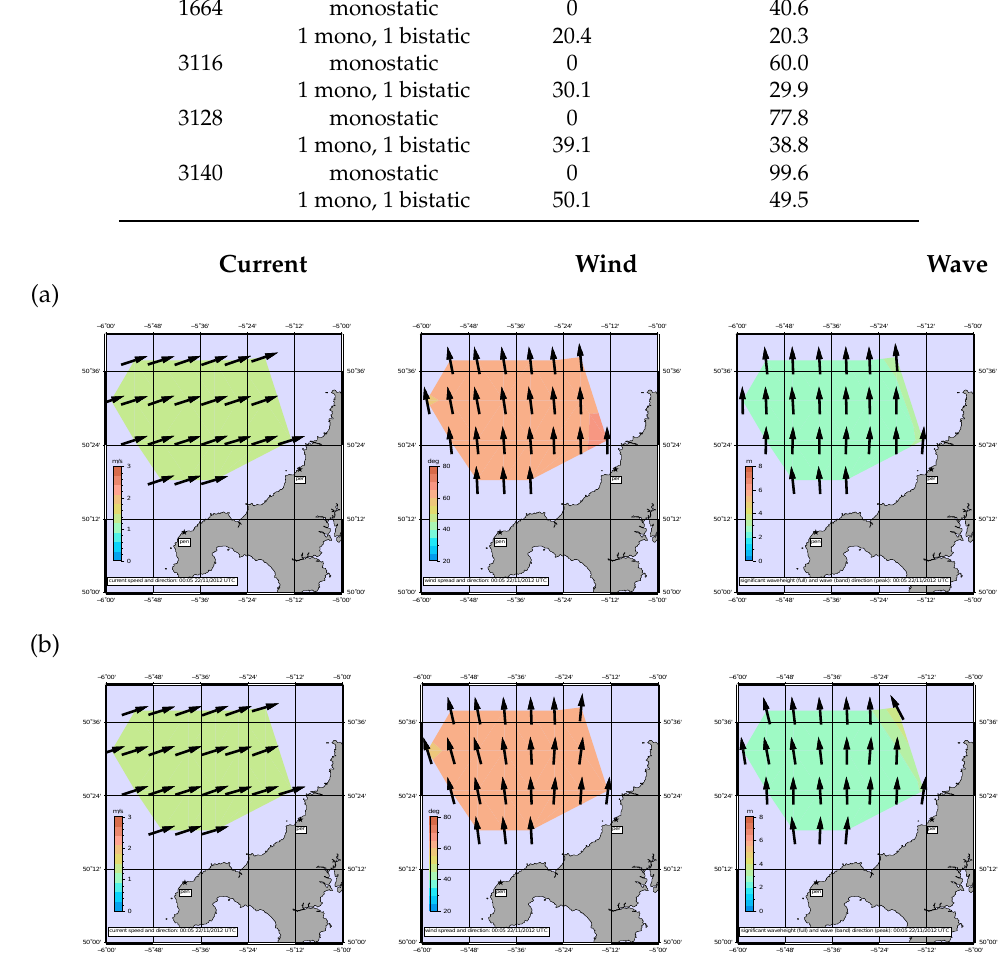
Table 2. Configuration parameters at selected cells. Cell Number Configuration Bistatic Angle Angle between Braggs